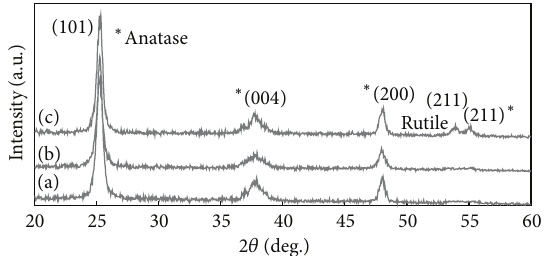
Figure 7: XRD patterns of CNT/TiO 2 films annealed at (a) 550 ∘ C, (b) 650 ∘ C, and (c) 750 ∘ C.